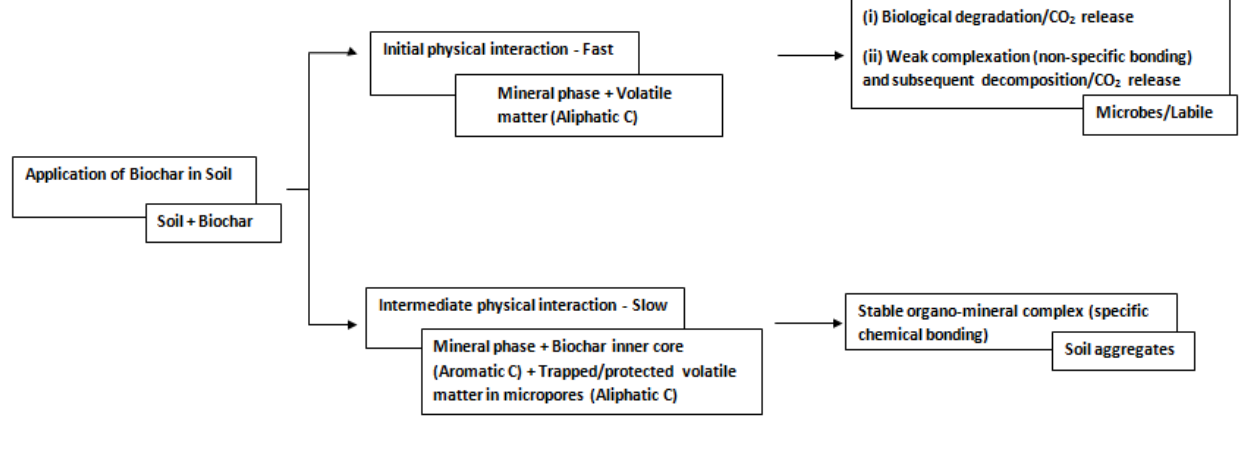
Figure 2. Schematic representation of two-phase complex formation.